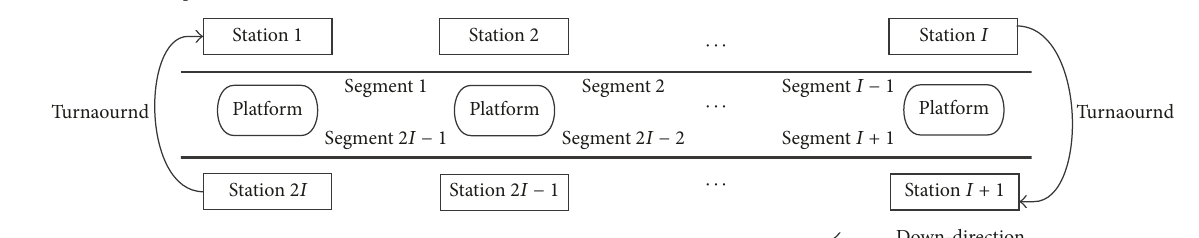
Figure 1: A bidirectional metro line with 2I